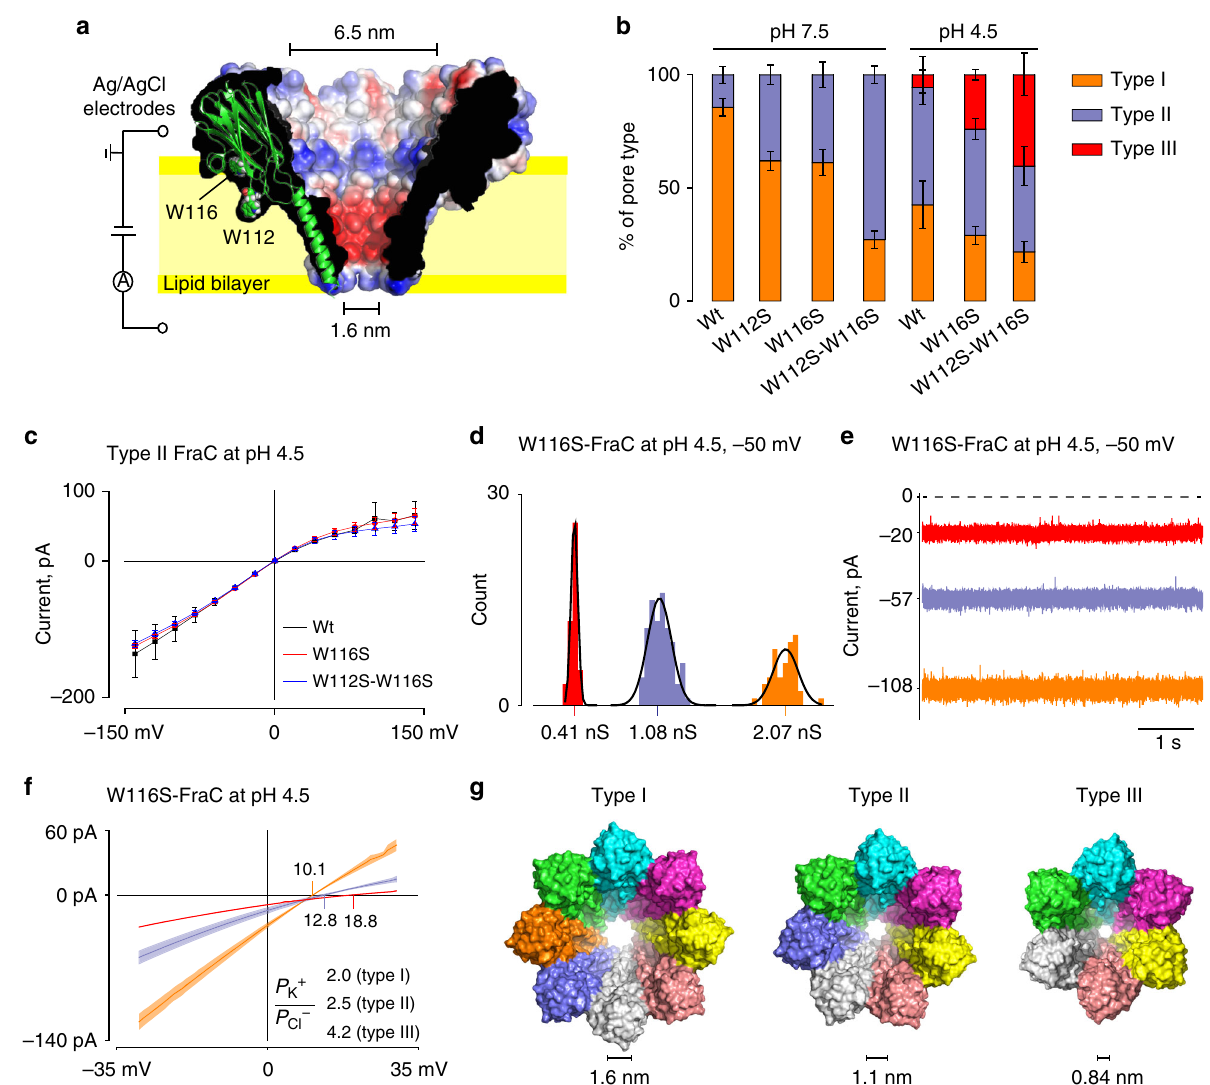
Fig. 1 Preparation and characterization of type I, type II, and type III fragaceatoxin C (FraC) nanopores. a Cut through of a surface representation of wild- type FraC (Wt-FraC) oligomer (PDB: 4TSY 33 ) colored according to the vacuum electrostatic potential as calculated by PyMOL. One protomer is shown